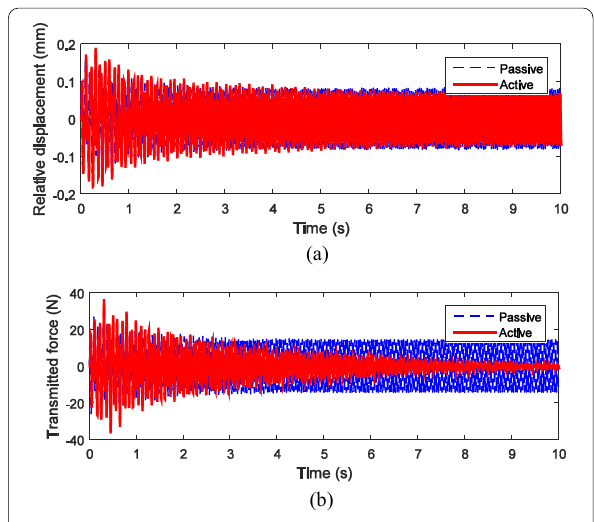
Figure 8 Comparison results of active mount and passive mount at the engine speed of 750 r/min: a the relative displacement and b the transmitted